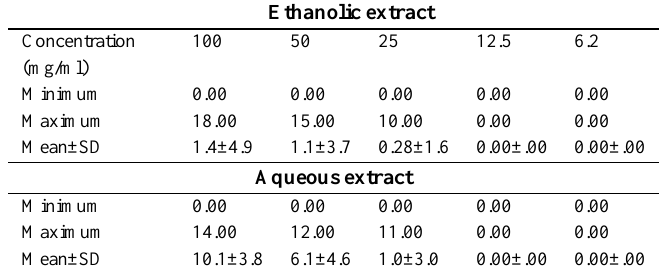
Table 2: Means of inhibition growth diameter of Ethanolic and Aqueous extract of L. sativum against Ssensitive Ps. Aaeruginosa Ethanolic extract